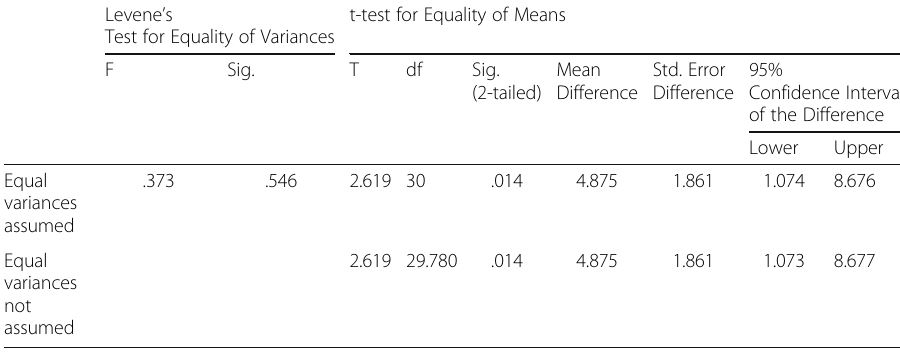
Table 11 Independent samples t-test; posttest of speech acts by groups Levene ’ s t-test for Equality of Means Test for Equality of Variances